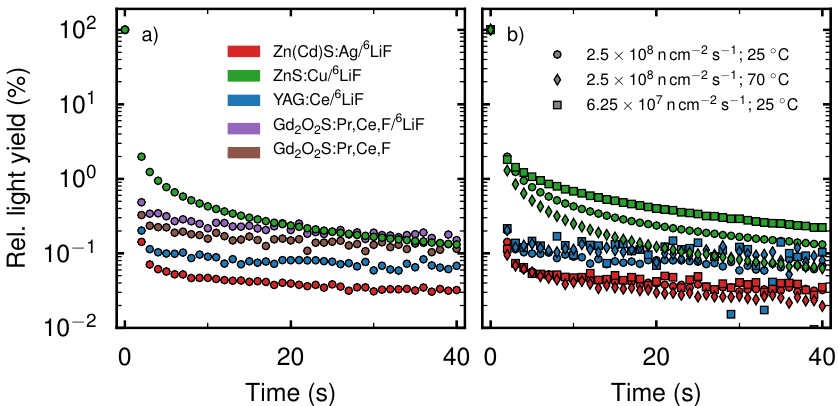
Figure 4. ( a ) Relative light yield decay of ZnS (green), ZnCd (red), YAG (blue), Gadox (brown) and Li-Gadox (purple) during the first 40s after the end of neutron irradiation. All data are normalized to the last irradiated image at t i = 0s. ( b ) Change of the light yield of ZnS (green), ZnCd (red) and YAG (blue) during the first 40s after shutting off the neutron beam. All data are normalized to the last irradiated image at t i = 0s. Round markers denote a measurement under standard conditions, whereas diamond markers indicate a higher temperature and square markers a lower neutron